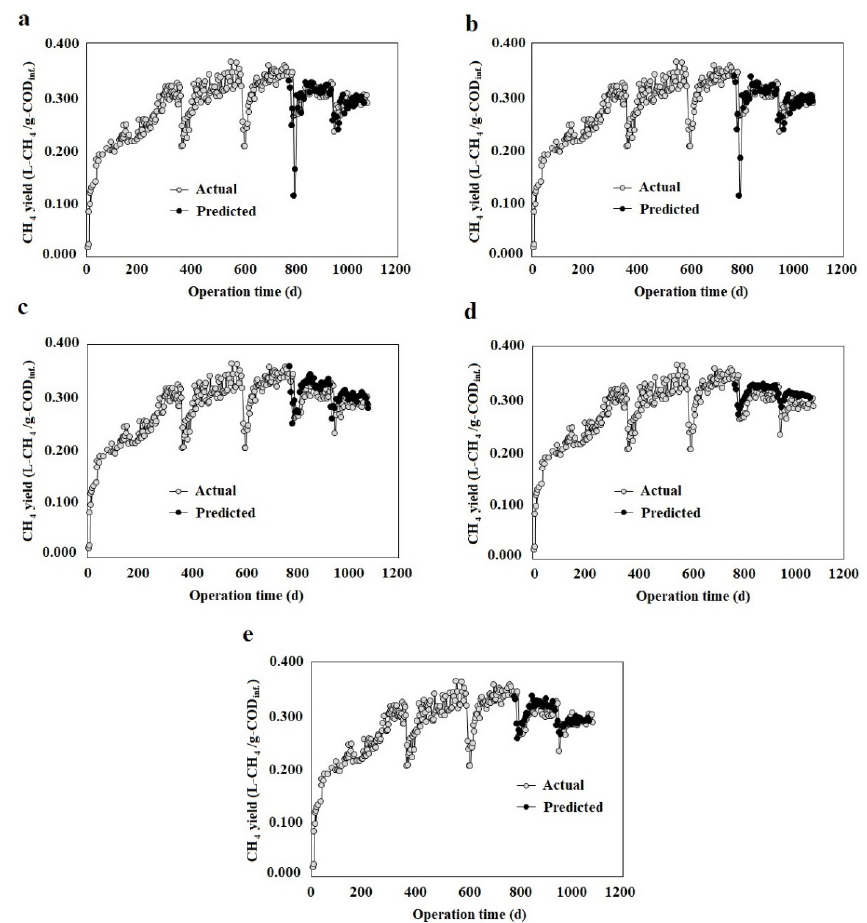
Figure 5. Results of 1-step ahead prediction of bio-electrochemical anaerobic digestion (BEAD) reactor using ( a ) random forest (RF), ( b ) extreme gradient boosting (XGboost), ( c ) support vector regression (SVR), ( d ) long short-term memory (LSTM), and ( e ) recurrent neural network (RNN).